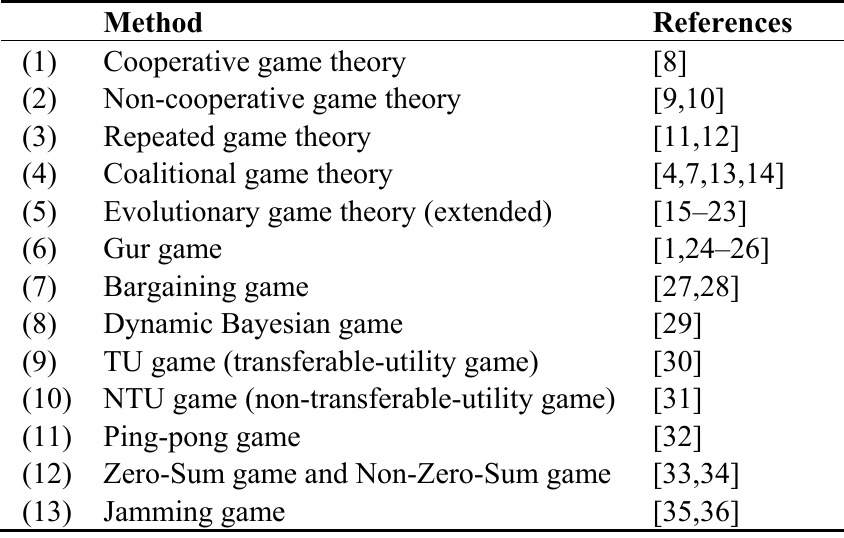
Table 1. Typical GT methods in